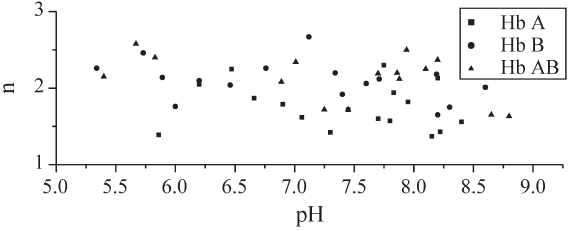
Figure 1 - pH dependence of P50 in blood. Buffer Tris-HCl 0.1 M. Showing regression lines in each phenotype.